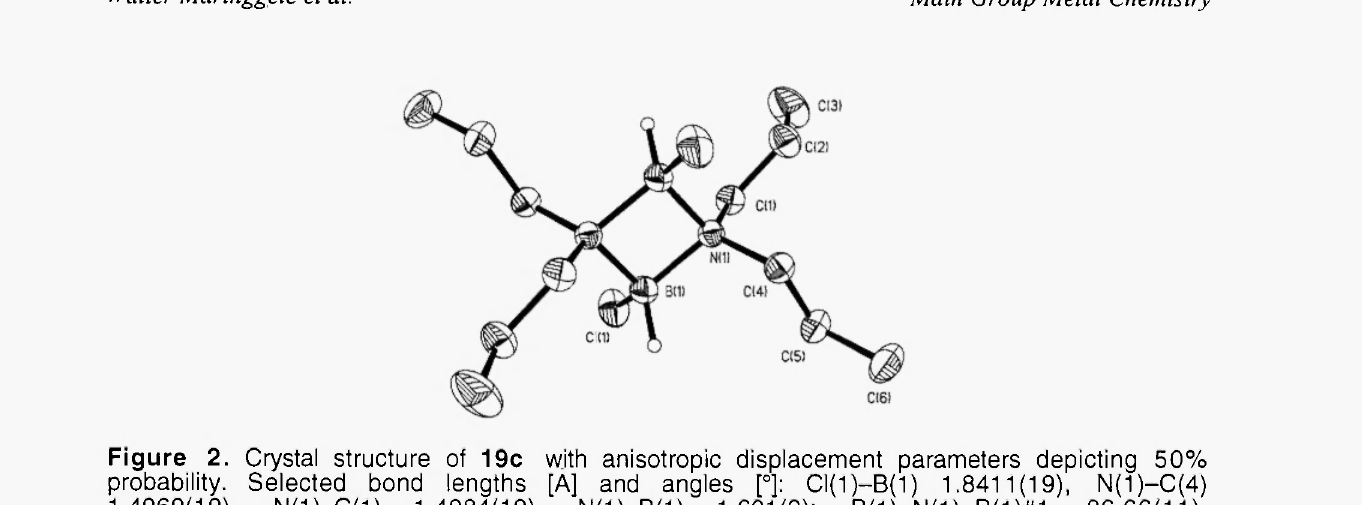
Figure 2. Crystal structure of 19c with anisotropic displacement parameters depicting 50% probability. Selected bond lengths [A] and